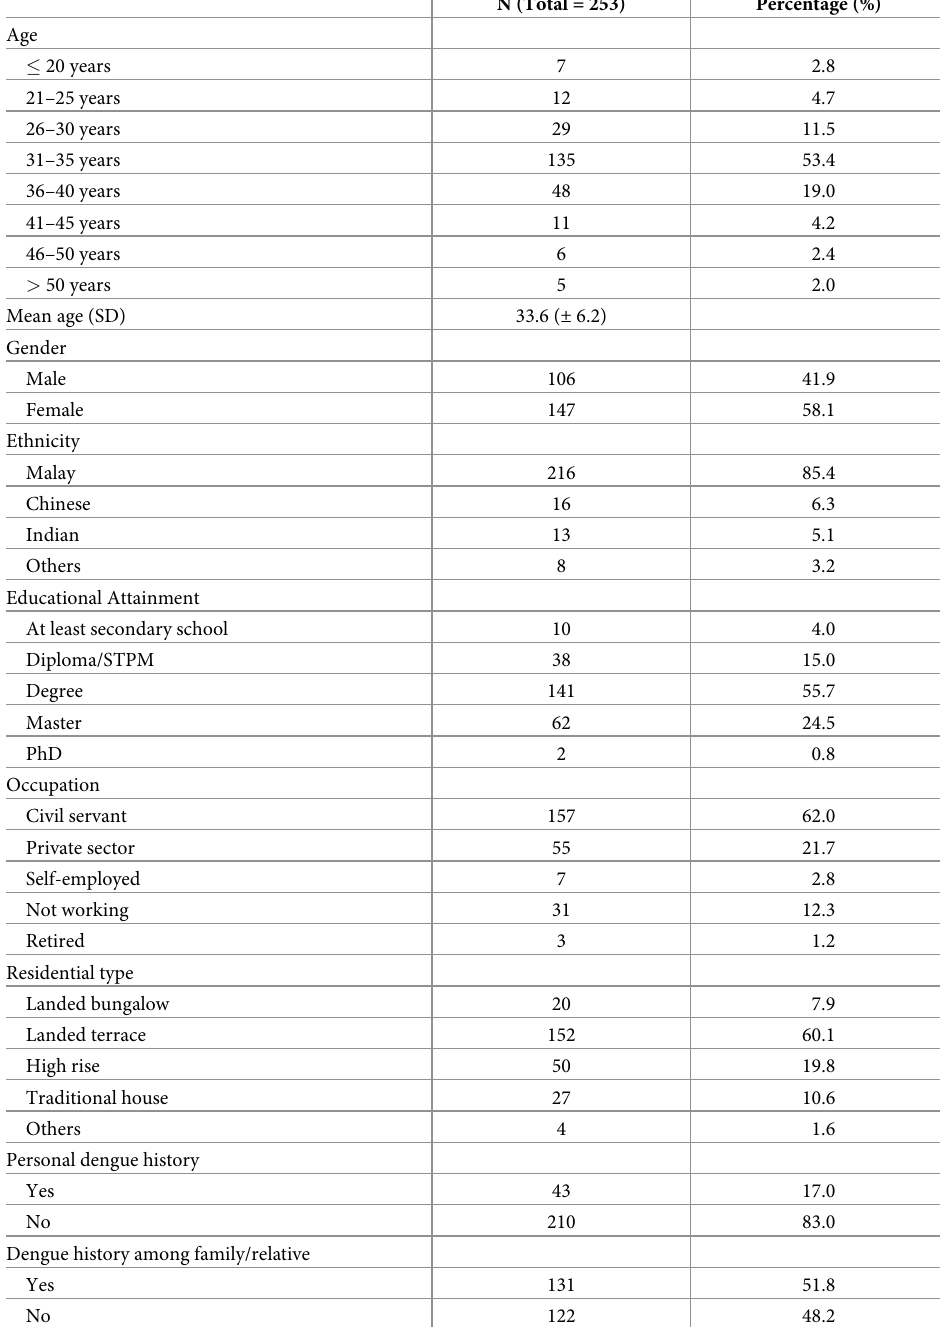
Table 1. Characteristics of online respondents in the